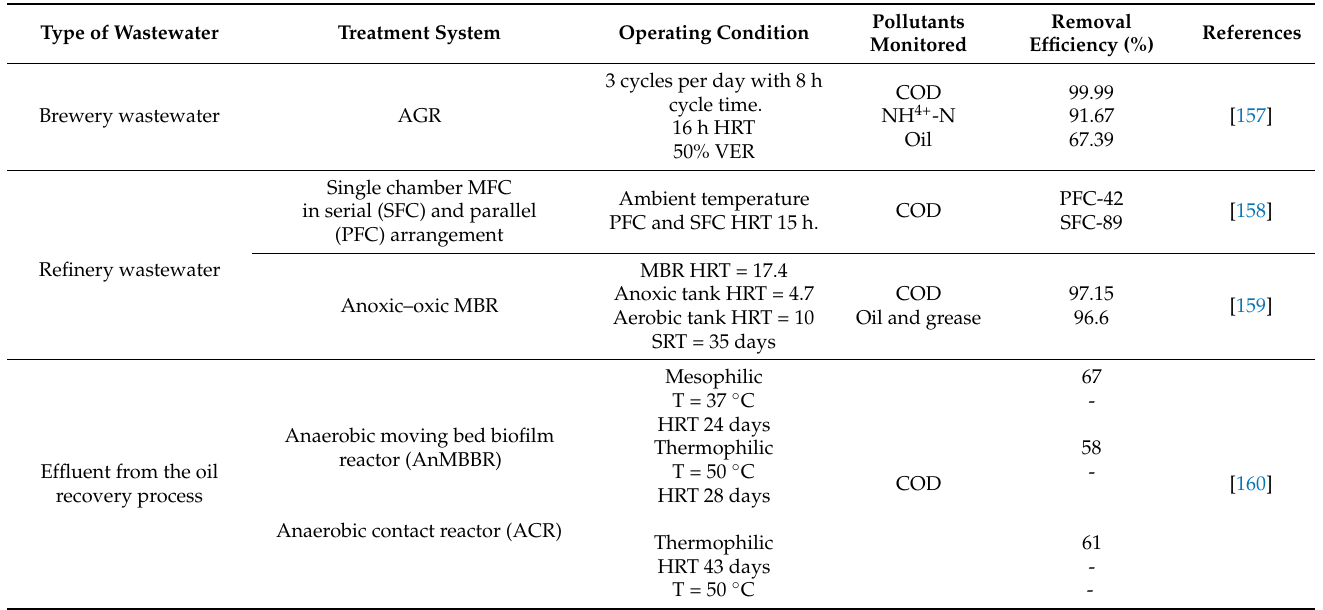
Table 6. Performance of biological treatments (BT) reported in the literature from 2018 to present.